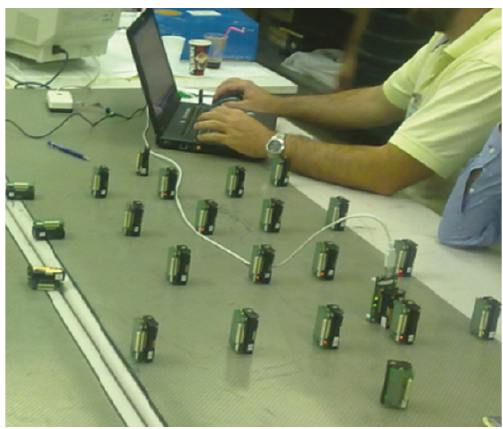
Figure 1: Part of the AWISSENET